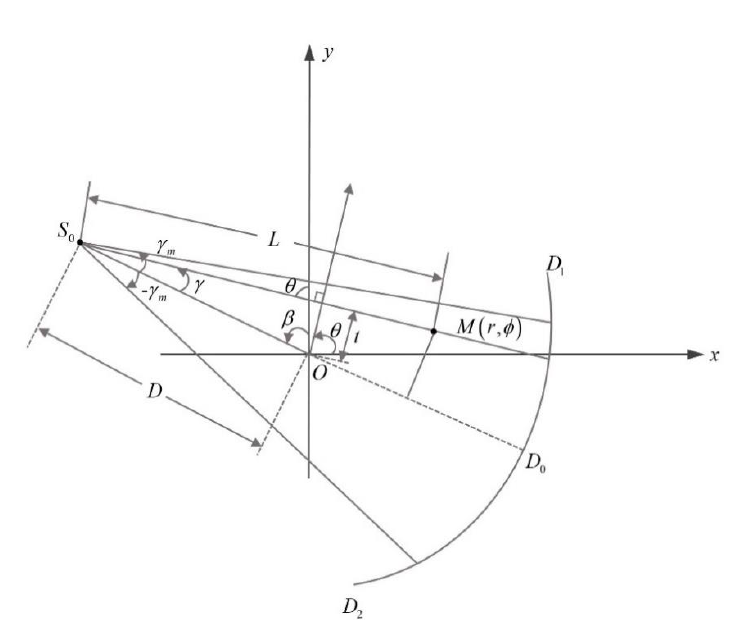
Figure 6. Geometric structure illustration of an equiangular fan beam system.